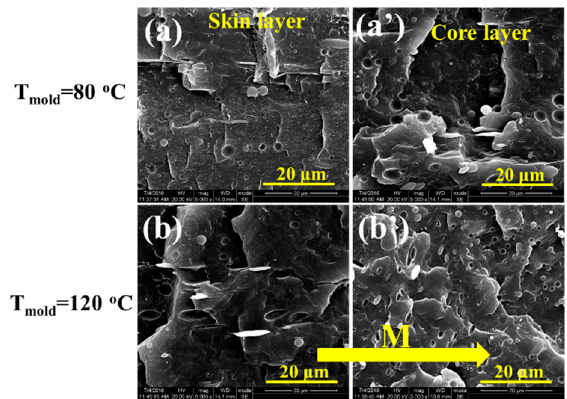
Figure 4. SEM images of iPP/PET (90/10) C-parts. M represents the flow direction.